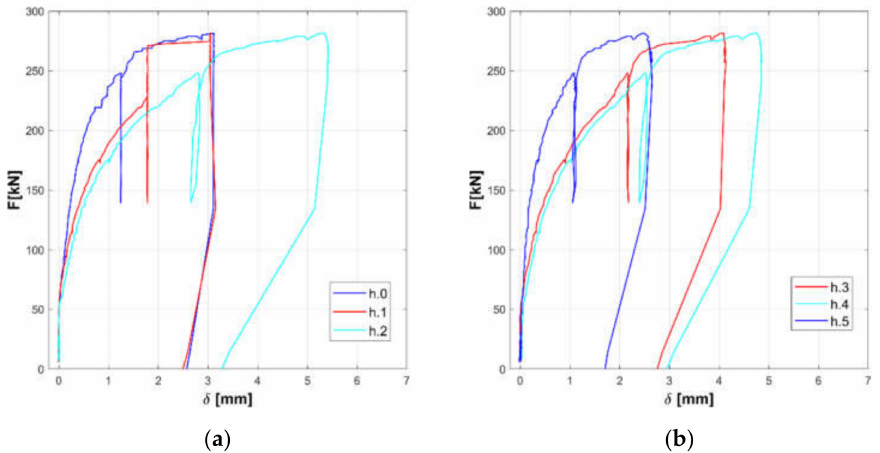
Figure 8. Experimental horizontal displacements of panel A: upper part ( a ) and lower part ( b ).